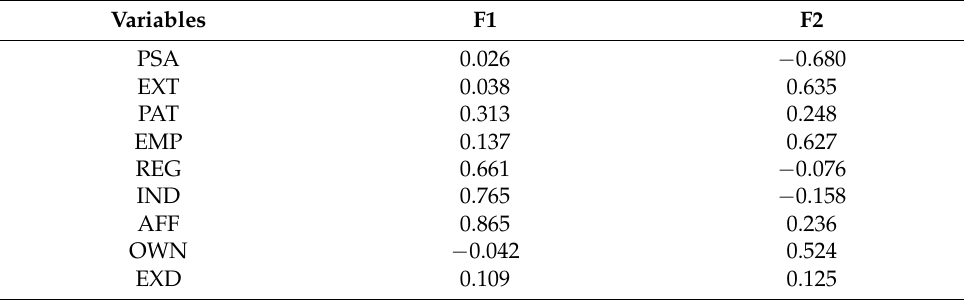
Table 4. Correlations between variables and factors after Varimax rotation.